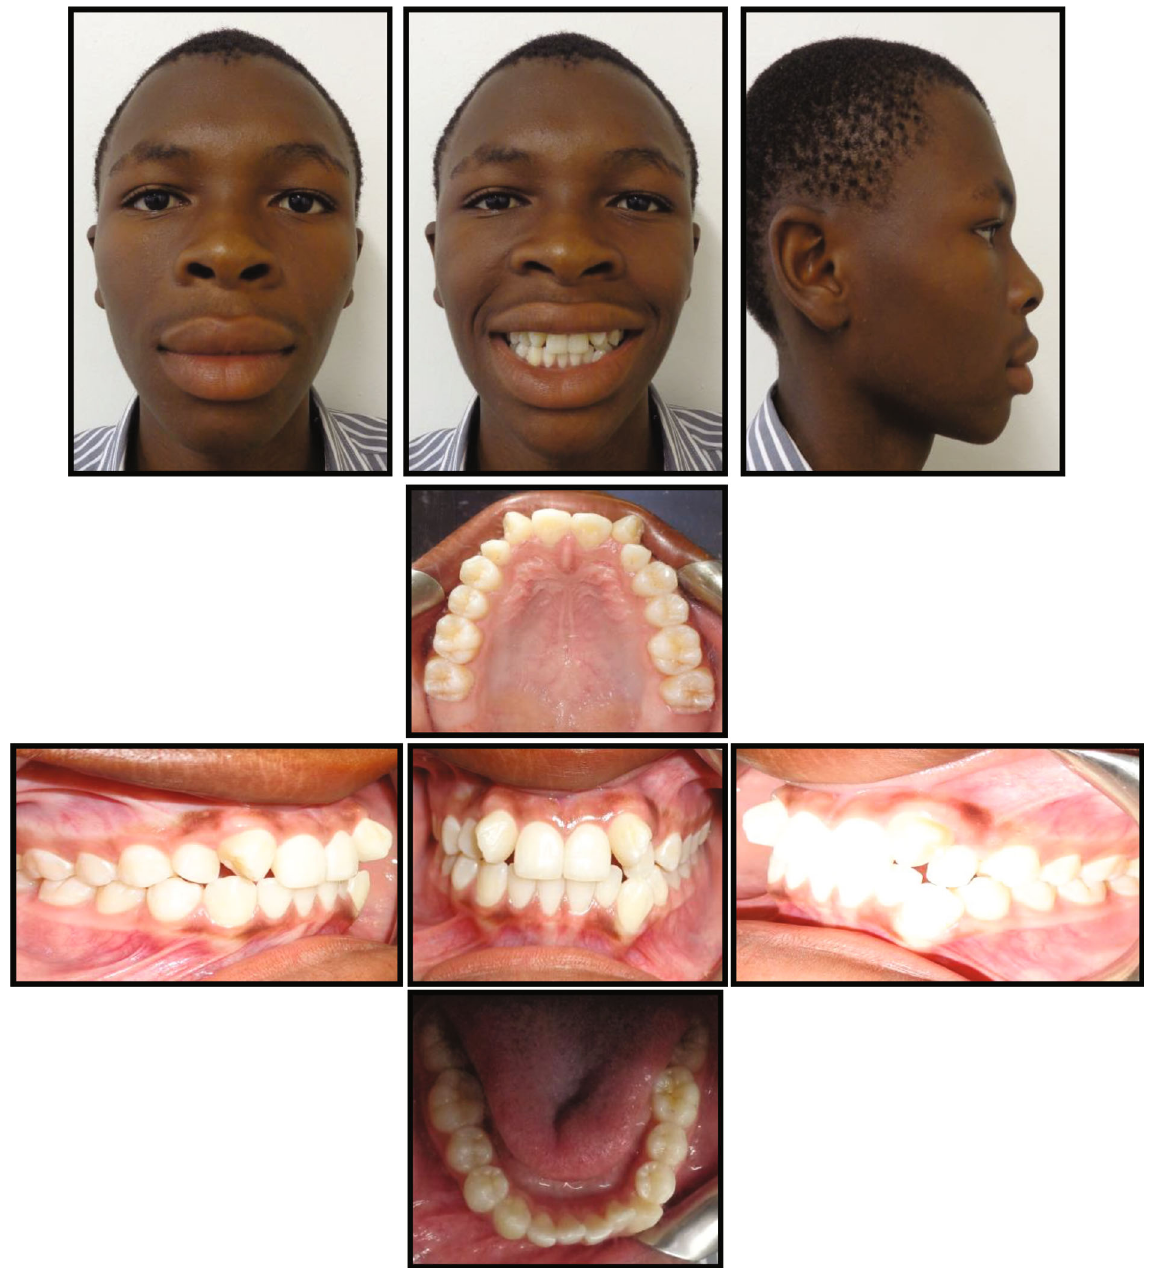
Figure 1: Pretreatment